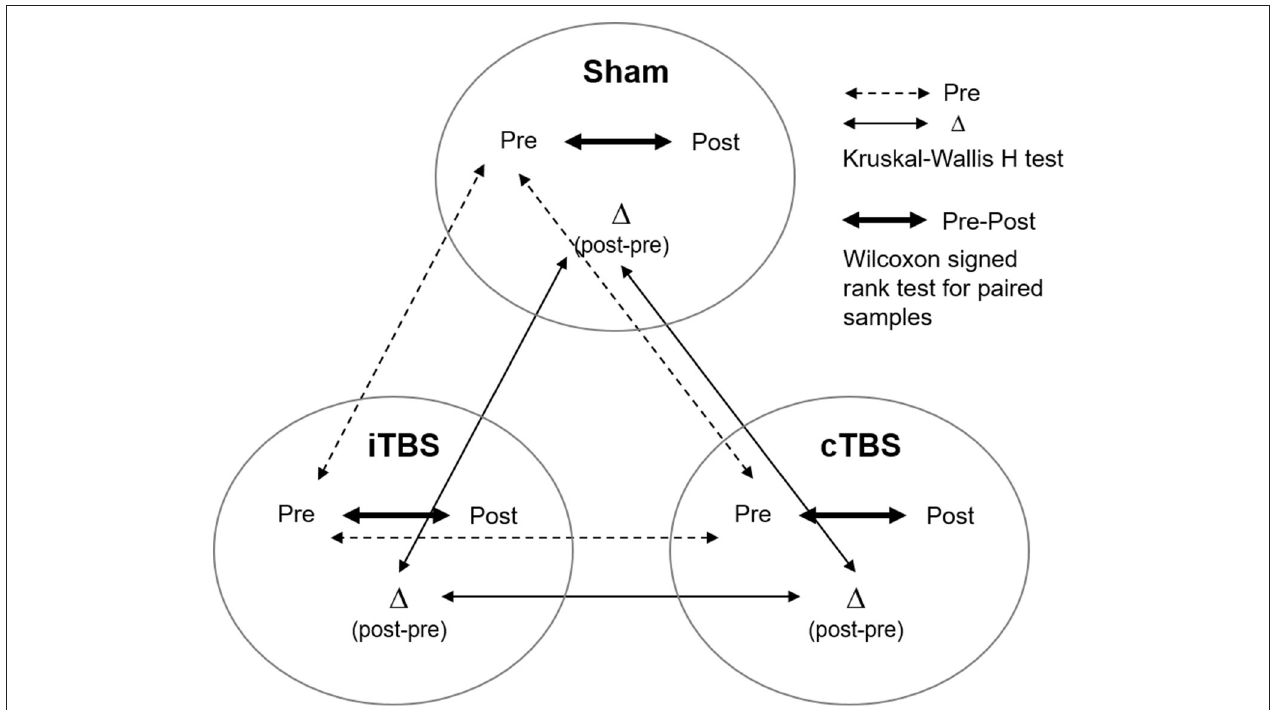
FIGURE 3 | Representation of the different analyses performed on the current study to compare behavioral outcomes (pre, post stimulation, and delta post-pre stimulation change) across (Kruskal–Wallis H- test) and within (Wilcoxon signed rank test) stimulation conditions (i.e., sham, cTBS, and iTBS). samples was used to compare performance between baseline (pre) and after (post) TMS within each condition ( Figure 3 , thick